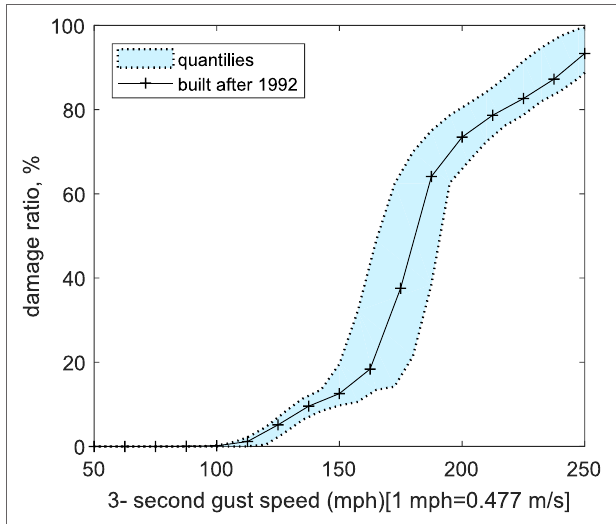
FigUre 7 | The vulnerability of mitigated house structure.